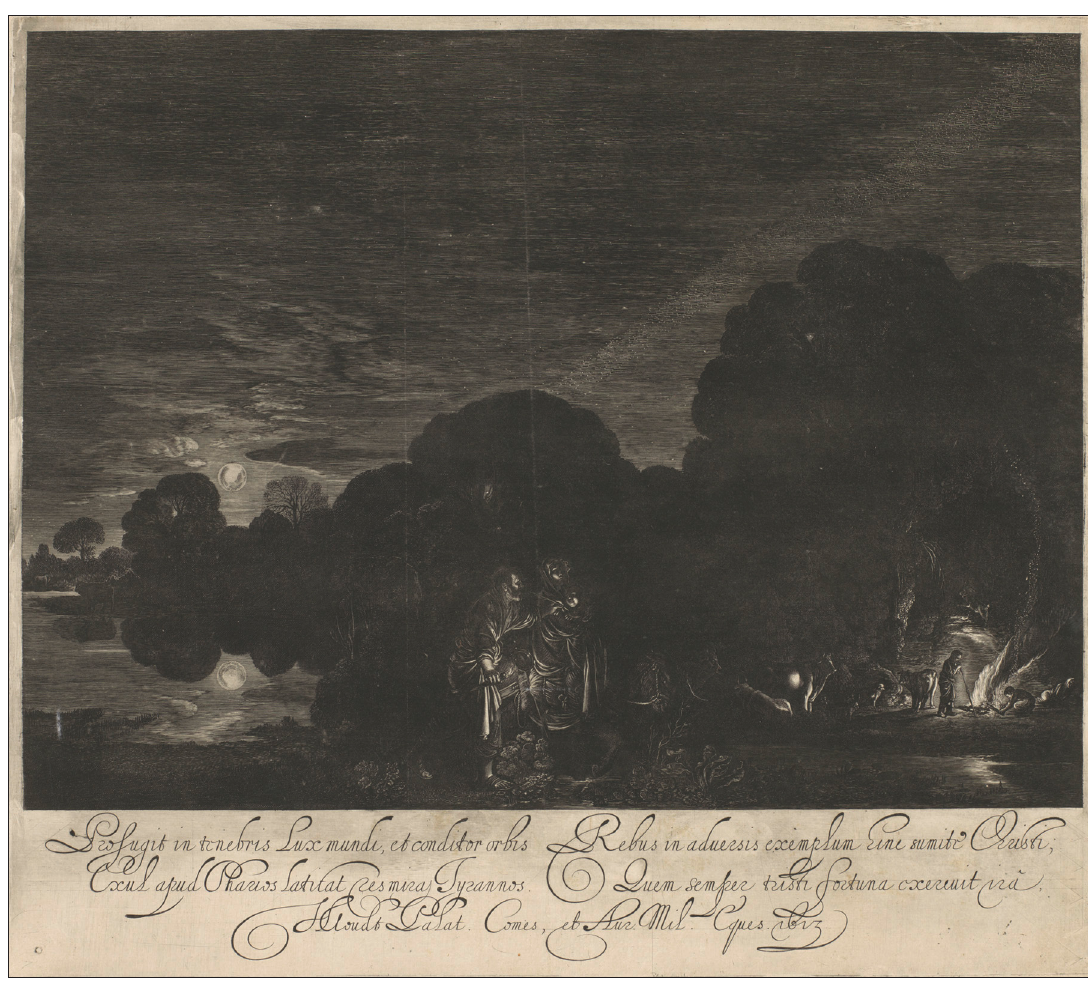
Figure 8: Hendrick Goudt, The Flight into Egypt , 1613, engraving and etching, printed on paper, 34.7 × 40.3 cm. © Rijksmuseum,